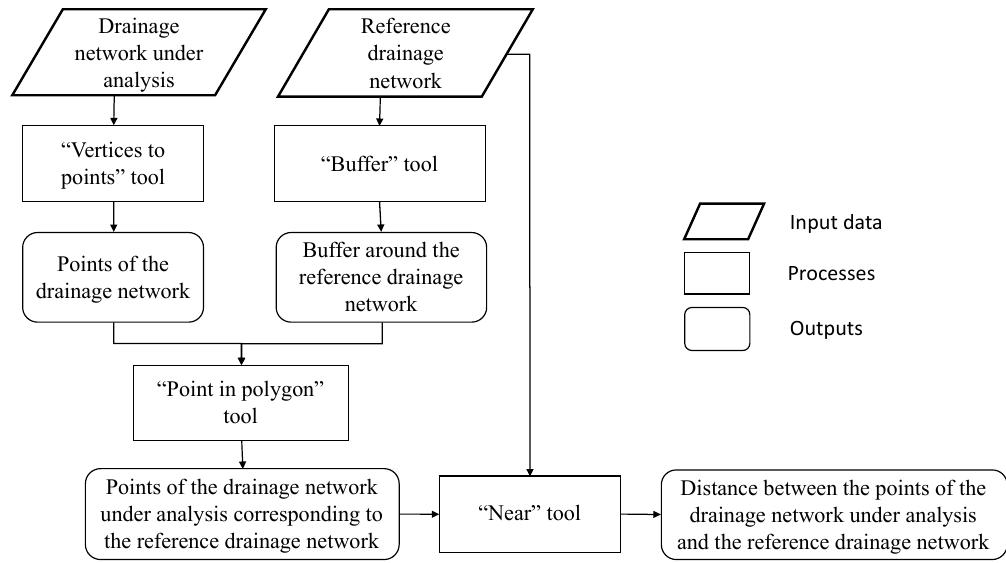
Figure 14. Flowchart for the calculation of the distance between sections of drainage networks under analysis identified as corresponding to the reference data.